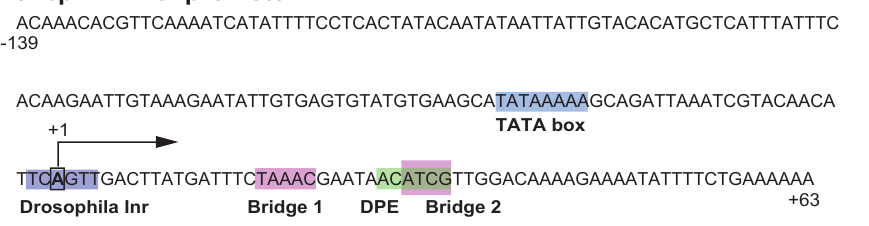
Figure 1. Identification of a minimal promoter for an inducible expression system in Pv11 cells. Luciferase activity was measured in vector-transfected Pv11 cells cultured under standard conditions (IPL-41 medium; ( A )) or with 600 mM trehalose treatment ( B ). A scheme of vector constructs is shown on the left and relative values in the luciferase assay are shown on the right. Normalized values are expressed as means ± standard deviations (SD). Each assay was performed with 5 replicates. ( C ) The predicted core promoter elements of the cytomegalovirus (CMV) and 202 bp minimal promoters. It is predicted that the 202 bp-promoter has Inr that closely resembles Drosophila one. Inr, initiator; DPE, downstream promoter element. TATA box, Inr, Bridge, and DPE are highlighted with blue, purple, red, and green, respectively. Transcription start sites are with + 1 and black arrow. The core promoter prediction program, the Elements Navigation Tool, was used with a default